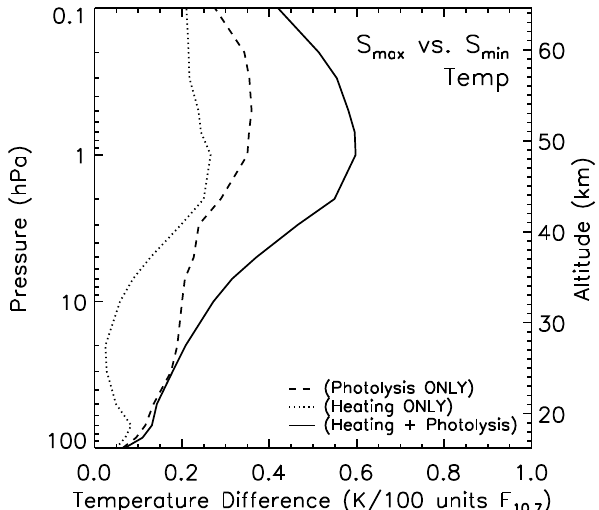
Fig. 3. Same as Fig. 2, but for the temperature response to the solar cycle.